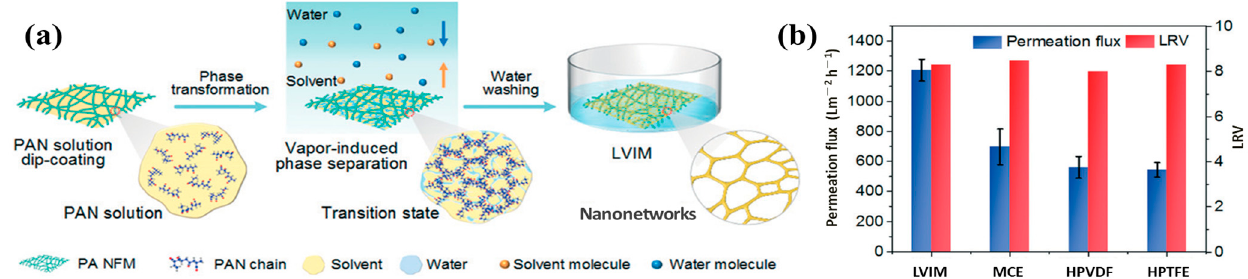
Figure 6. ( a ) Schematic diagram of the preparation procedure of porous microfiltration membranes; ( b ) bacterial removal efficiency of porous microfiltration membranes and commercial membranes. Reprinted with permission from Ref. [119], Copyright 2020, The Royal Society of Chemistry.